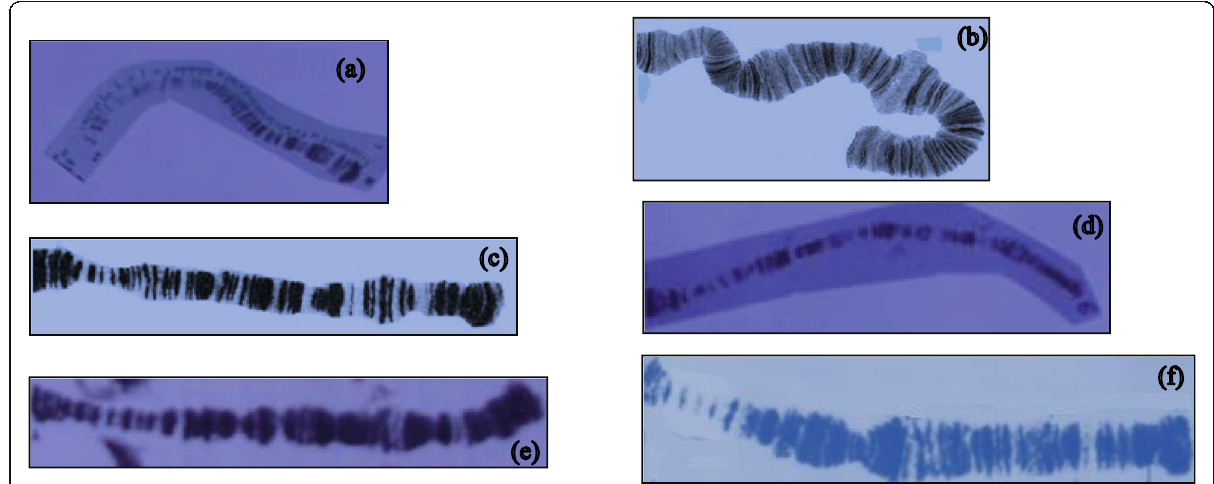
Fig. 3 Arm B of the polytene chromosomes of six species of Chironomus. a C. javanus. b C. dorsalis. c C. riparius. d C. matures. e C. maddeni.